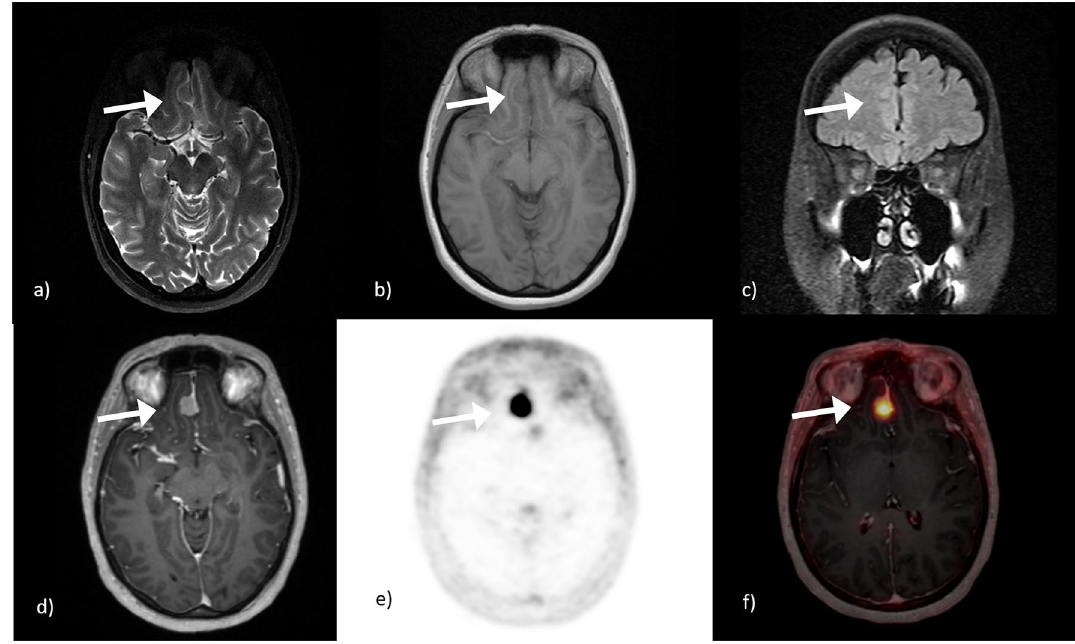
Figure 1. 61 years old female patient with a typical falcine meningioma in the front. The first row presents the difficulty in differentiation the meningioma from the surrounding parenchyma due to isointensity. Here presented for ( a ) T2 TSE with CSF cleft sign, ( b ) T1 FL2D and ( c ) TIRM without edema. However the falcine meningioma can be easily detected after contrast medium injection in MPRage ( d ) after 68 Ga-DOTATOC injection for PET ( e ) and in fusioned imaging PET/MRI ( f ).